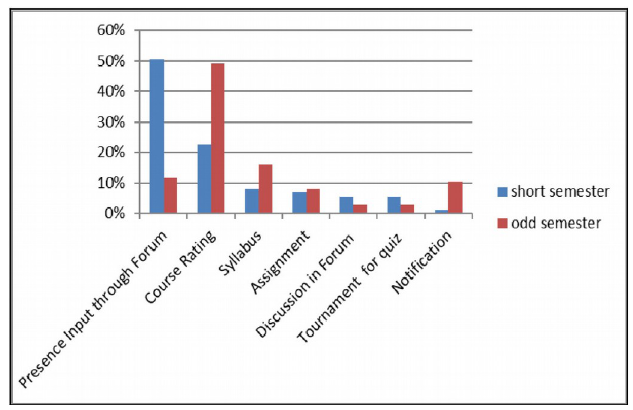
Figure 8. Rank of helpful